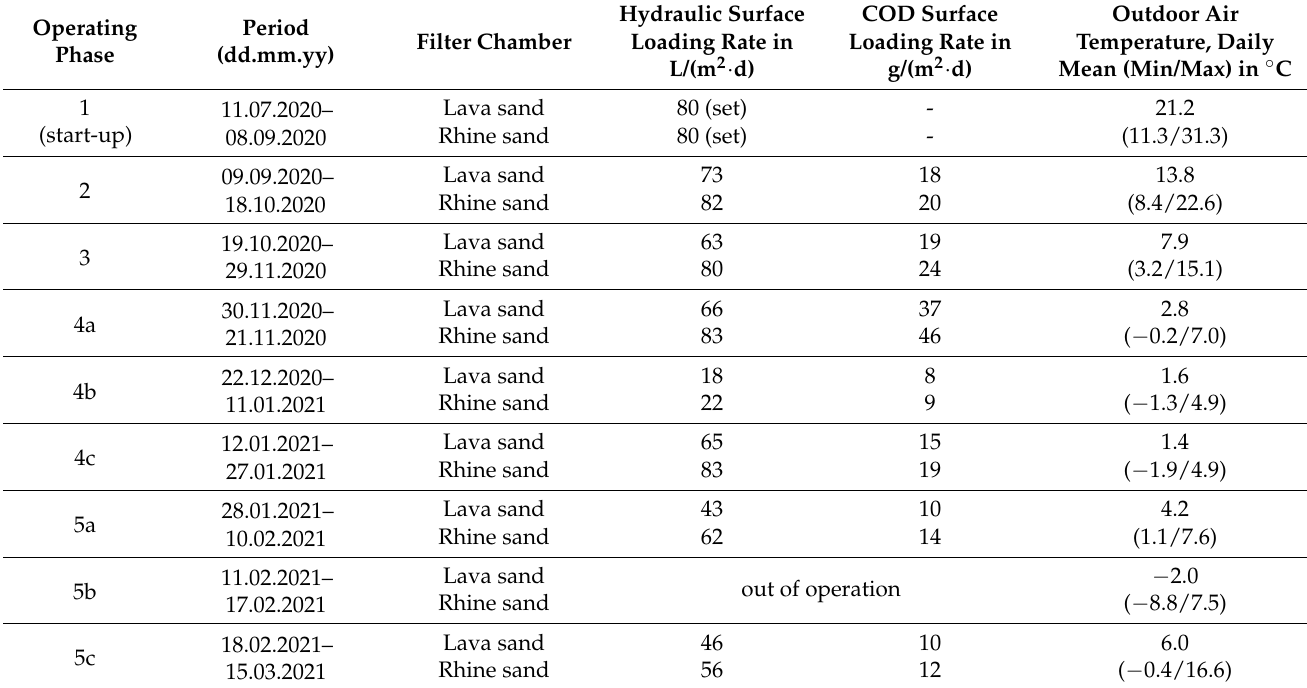
Table 1. Operating phases for the vertical-flow constructed wetland, from July 2020 to March 2021 in Stuttgart North, Germany. Operating